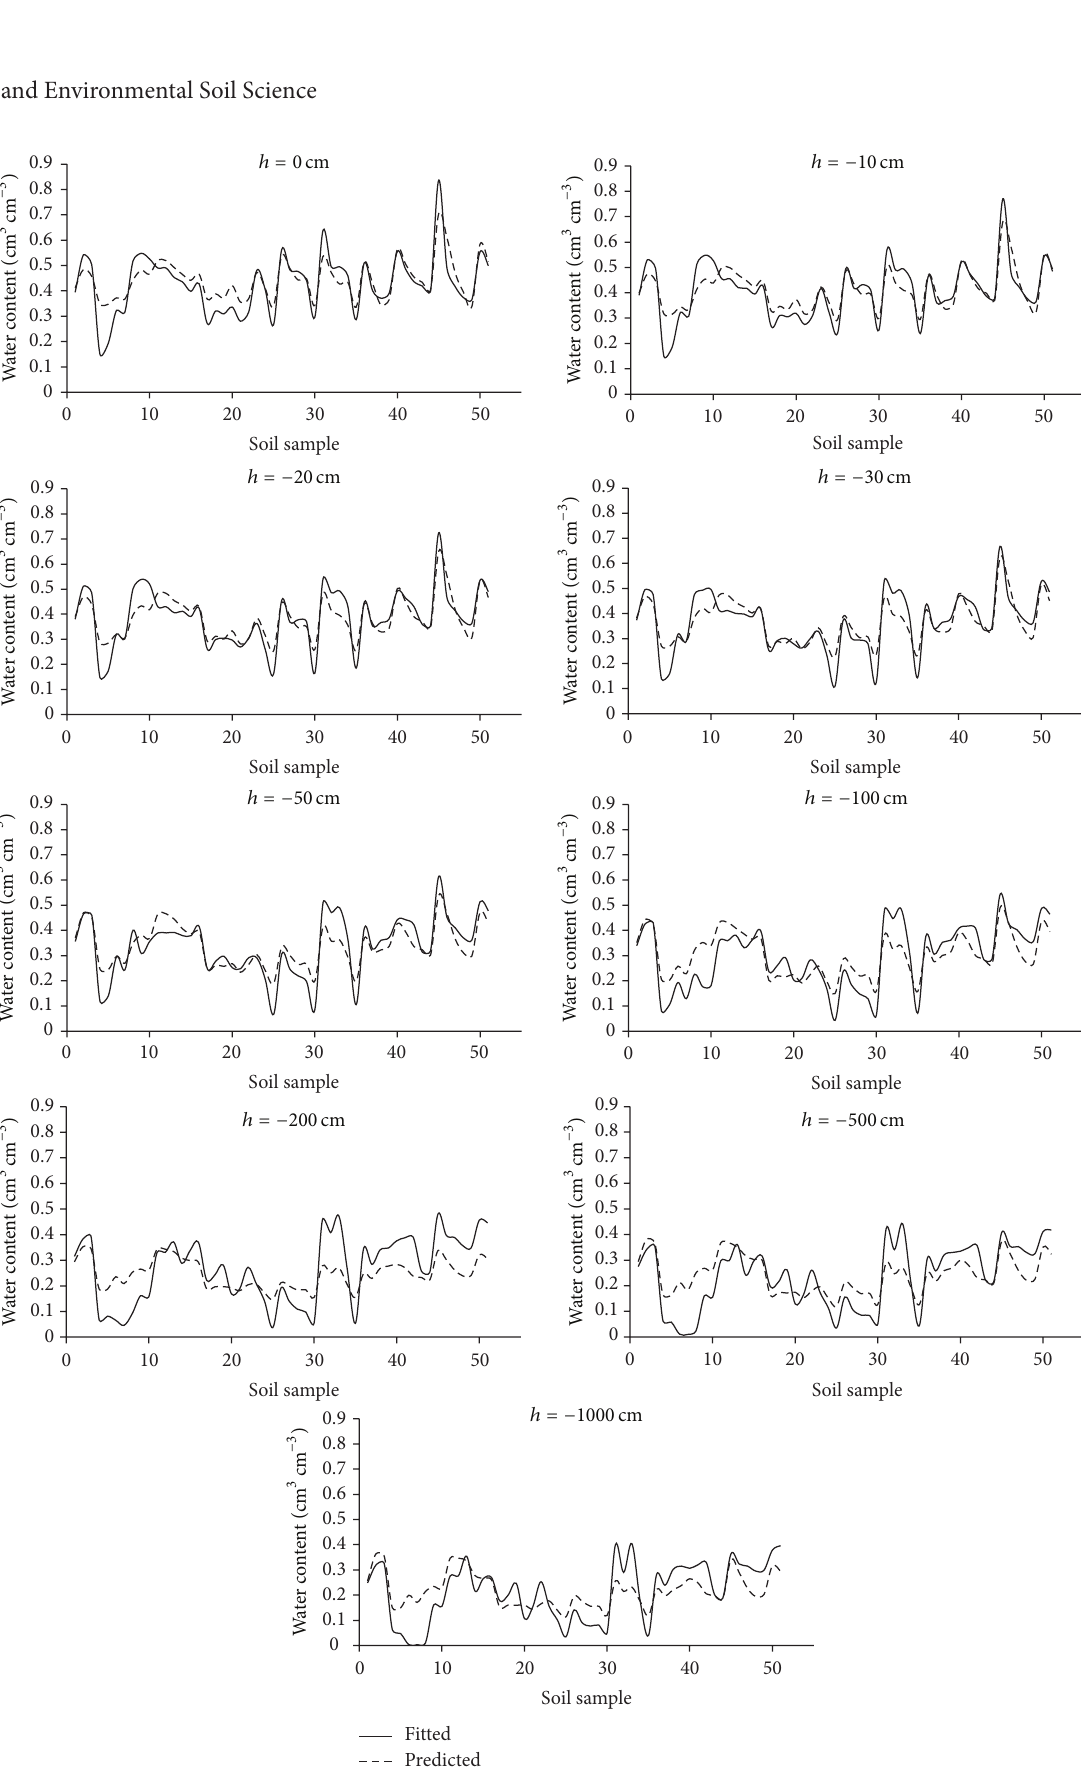
Figure 7: Fitted and predicted water contents obtained by ANN 2 model and van Genuchten parameters, respectively, where ℎ is the matric